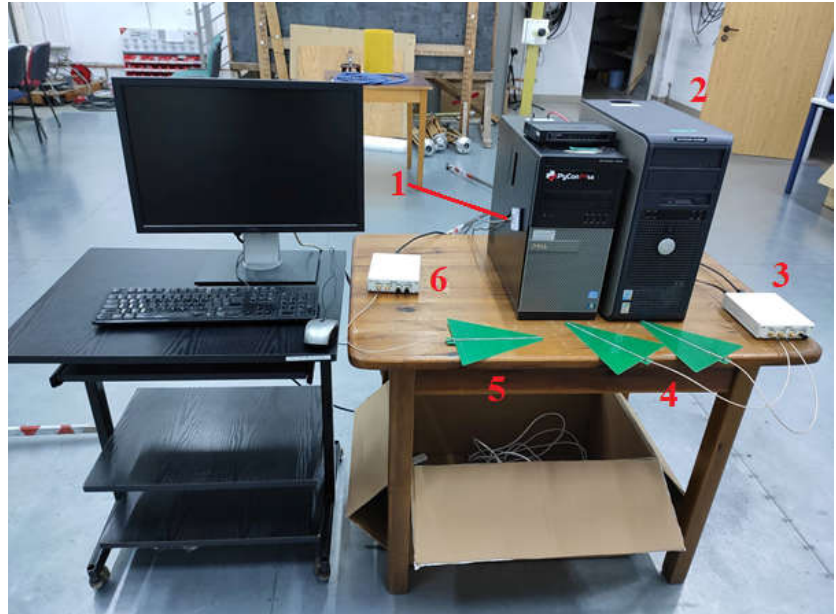
Figure 5. Testbed hardware: 1—AP Wi-Fi, 2—EPC Server, 3—USRP B210 (eNB), 4 and 5—set of antennas, and 6—USRP B210 as spectrum analyzer for spectrum observation.